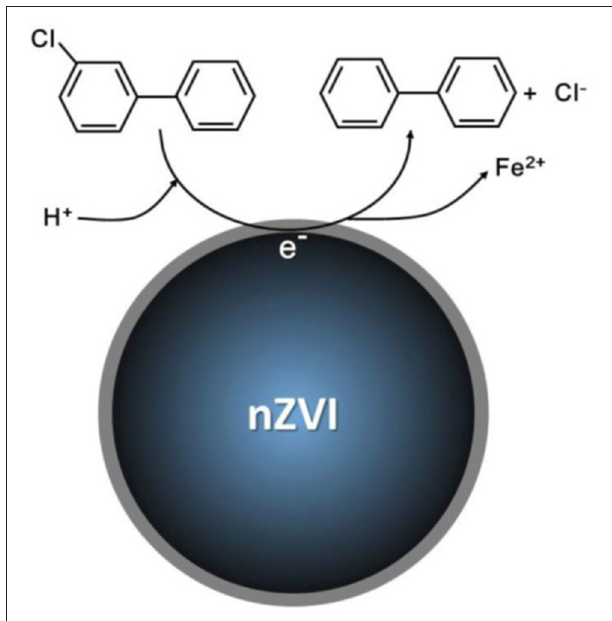
FIGURE 2 | Proposed mechanisms for abiotic dechlorination of PCBs: Electron transfers from Fe 0 to monochlorobiphenyl ( Gomes et al.,